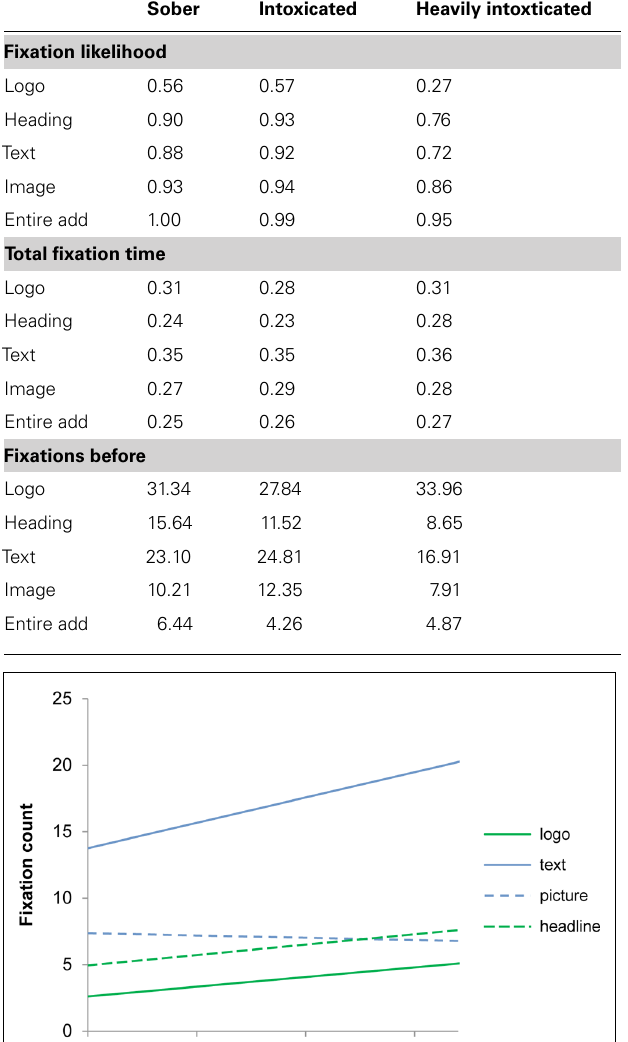
Table 4 | Fixation likelihood, total fixation time and fixations before to the four add elements and the entire ad according to three levels of intoxication: sober (BAC = 0%), intoxicated (BAC > 0% and ≤ 0.02%), heavily intoxicated (BAC > 0.02%).